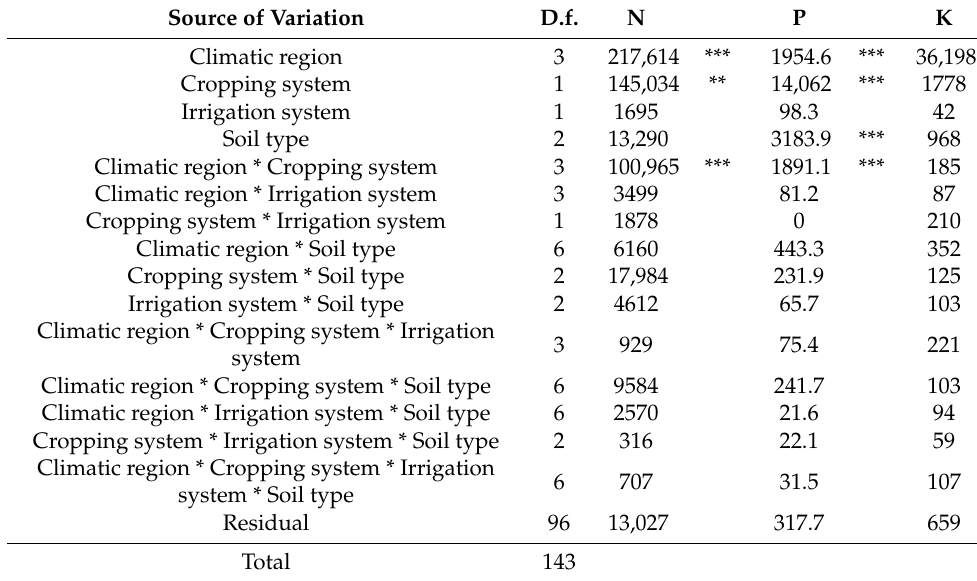
Table A1. Analysis of variance table showing mean squares for nutrient (NPK) uptake in different cropping systems, soil types, climatic regions and irrigation